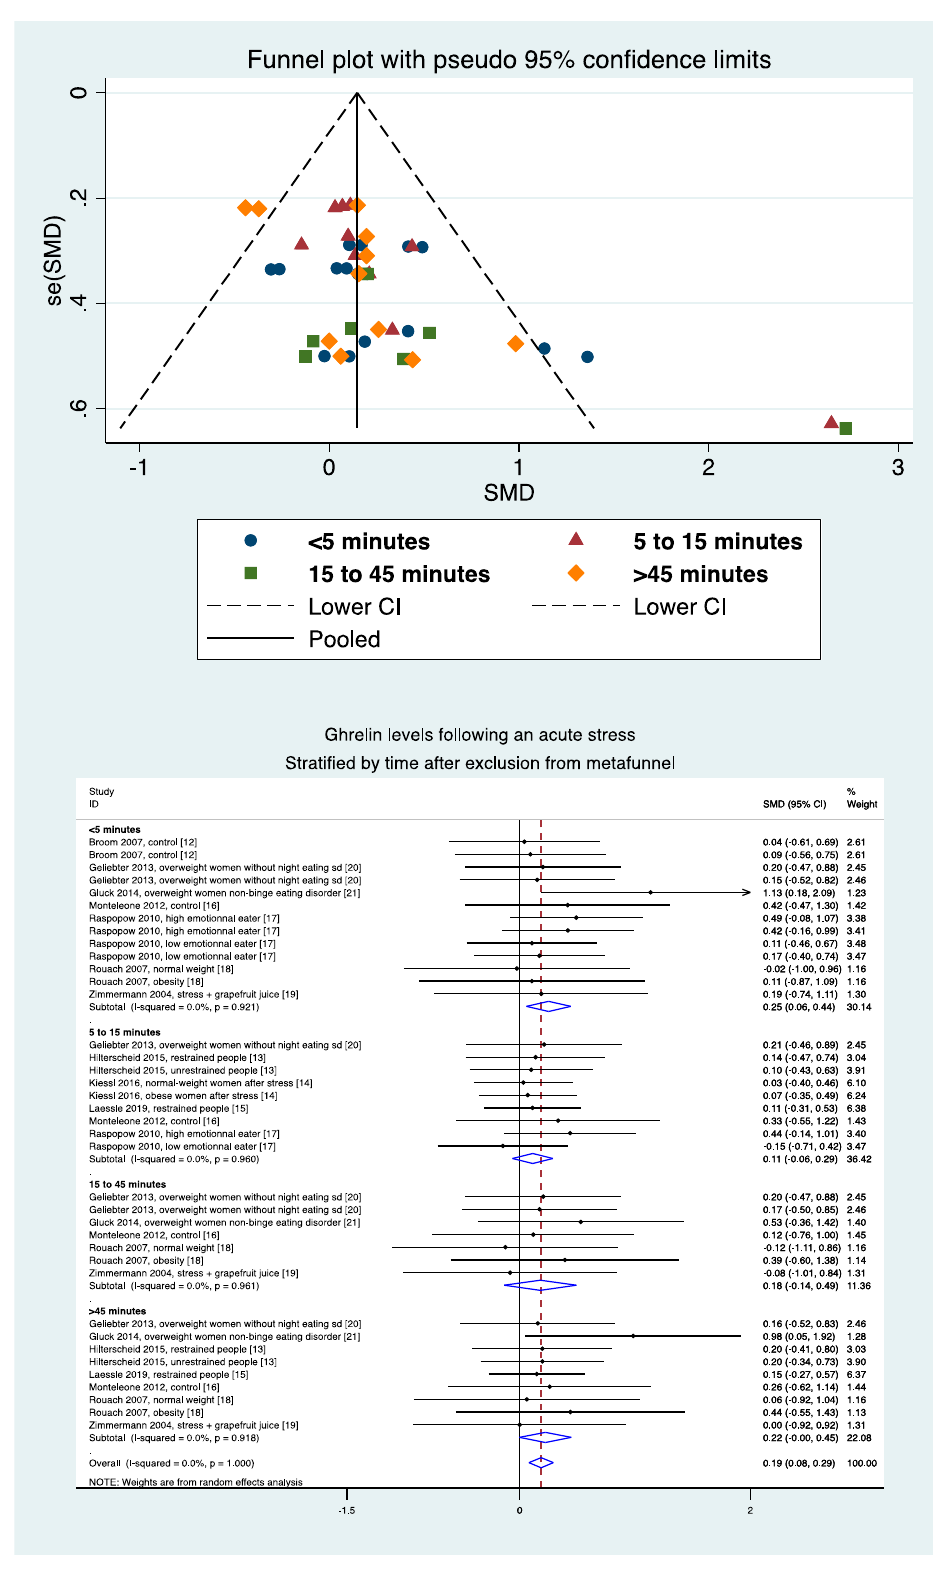
Figure 7. Metafunnel and meta-analysis of ghrelin levels after acute stress compared to baseline levels after exclusion from the metafunnel, stratified by time after the initiation of the acute stress intervention.